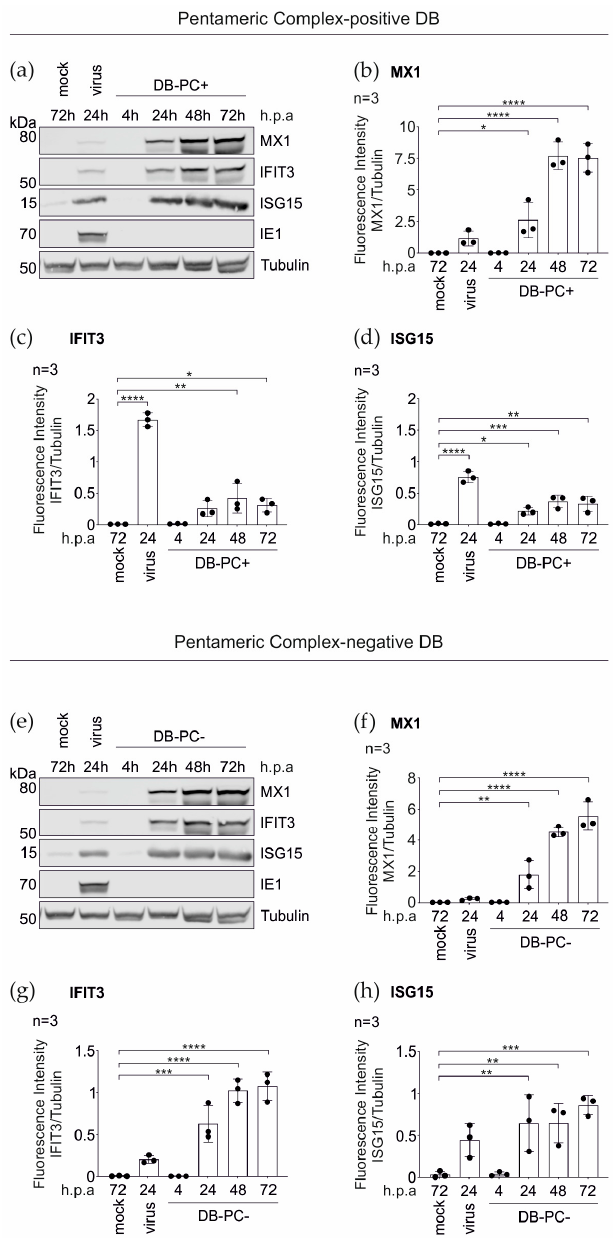
Figure 3. Western blot analysis of the IRG expression in HFFs following the DB-exposure. 5 × 10 5 HFFs were incubated with 20 µ g UV-inactivated DBs of the PC-positive HCMV strain TR- ∆ GFP (( a – d ); DB-PC+) or the PC-negative HCMV strain TR-BAC (( e – h ); DB-PC − ). Cell lysates were prepared at indicated time points and subjected to SDS-PAGE and immunoblot analyses. Untreated cells (mock) and HCMV infected cells (strain TR- ∆ GFP, 100–300 genomes per cell, virus) served as controls. The membranes were probed with antibodies against the IRGs MX1, IFIT3, and ISG15. An antibody against the viral IE1-protein was used to exclude contamination of the DBs with the infectious virus. Tubulin was probed as the sample loading control. For the quantification, the ratio of the measured fluorescence intensity of each IRG protein band to the corresponding tubulin band was calculated using the LICOR Image Studio Lite (Ver 5.2.5) software ( b – d , f – h ). The values of three independent experiments were plotted. Error bars represent the SD. Comparisons between the conditions were calculated using a one-way ANOVA test. The mean of each condition was compared to the mean of the control (mock) condition. * p < 0.05; ** p < 0.01; *** p < 0.001; **** p < 0.0001. n = Biological